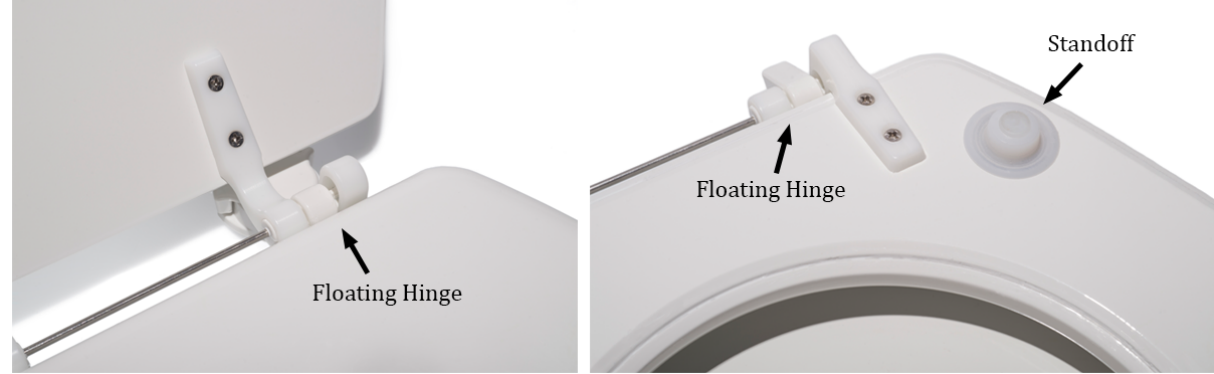
Figure 3. A floating hinge ensures that the weight on the seat is completely captured by the load cells under each standoff rather than having a portion of it carried by the hinge. This is a requirement for accurate ballistocardiogram monitoring on a toilet